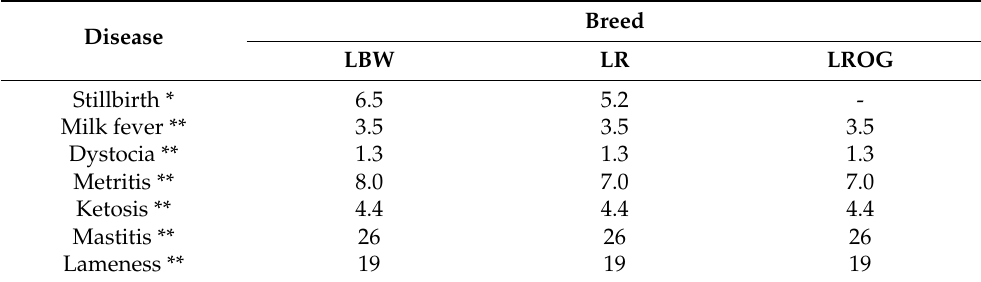
Table 5. Number of treatments (per 100 cow-years) for the respective diseases in the breeds LBW, LR and LROG.